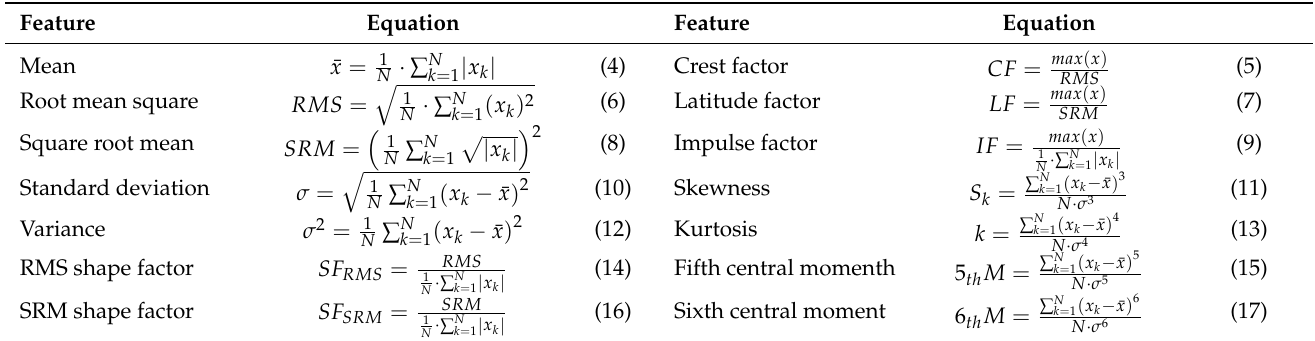
Table 1. Statistical time-domain